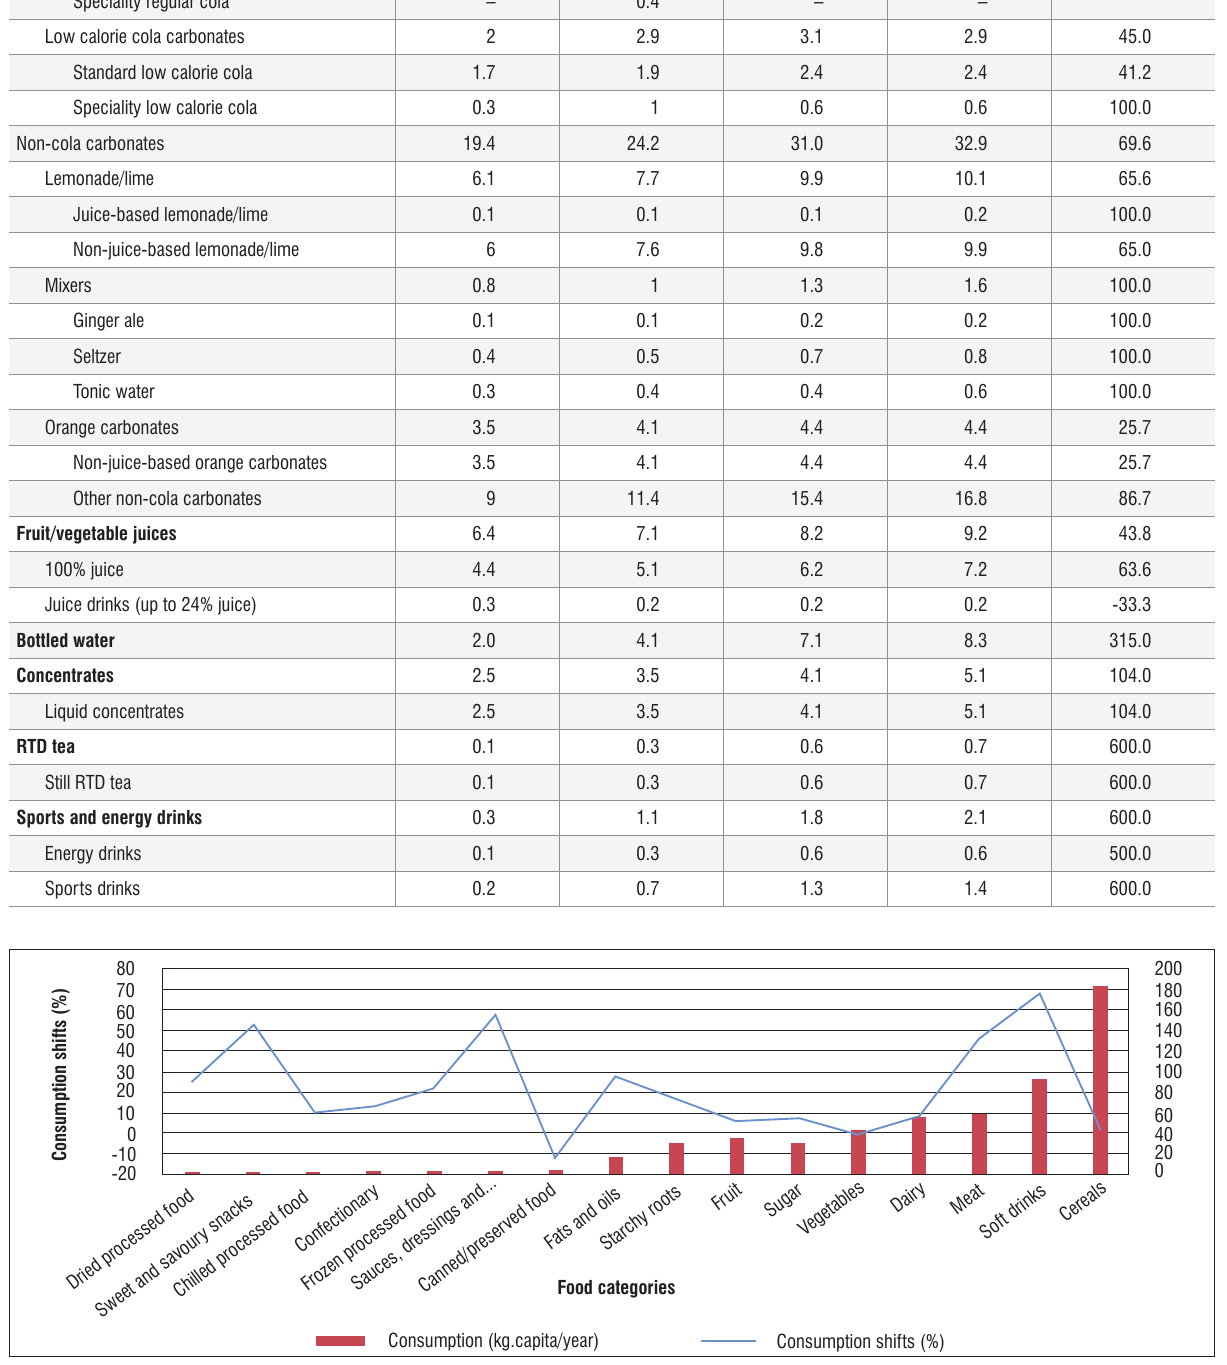
Figure 1: Per capita consumption and shifts in consumption of specific food categories in South Africa from 1994/1999 to 2009/2012 (FAOSTAT FBS & Euromonitor PFBC data